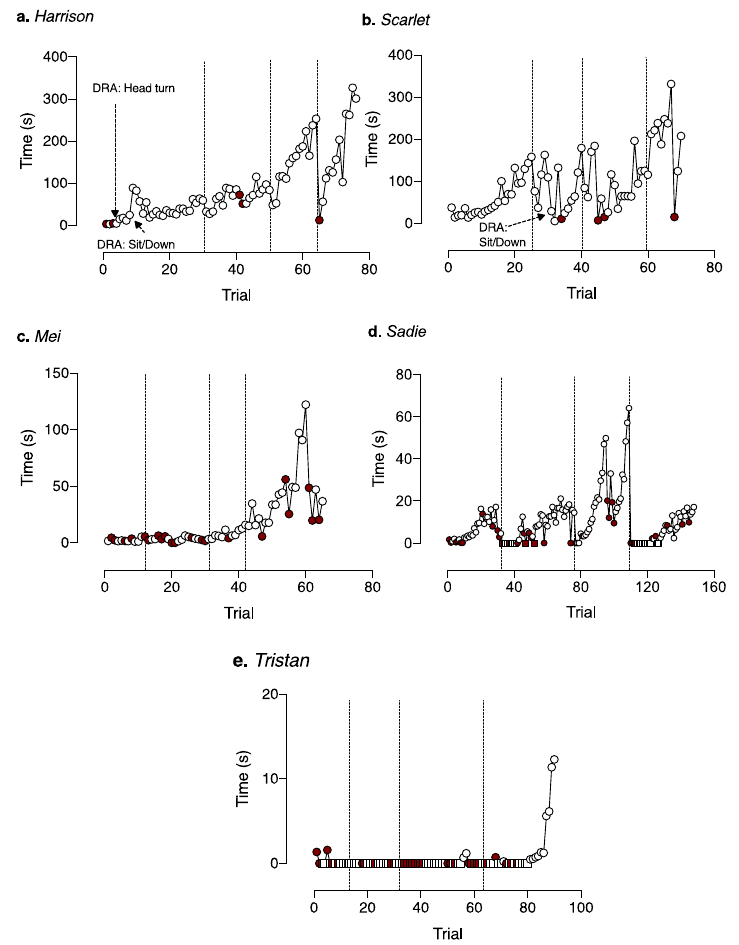
Figure 3. Trial-by-trial data for each dog ( a. Harrison; b. Scarlet; c. Mei; d. Sadie; e. Tristan) during Treatment. On each trial, we plotted either the time the dog was alone (for successful trials with no PB; open symbols) or the latency to PB on unsuccessful trials (filled symbols). Circle symbols indicate that the criteria were such that the owner was exiting the house on that trial. Square symbols indicate criteria were such that the owner was staying inside the house on that trial. For all trials in which the owner remained in the house, time dog was alone are recorded as 0 s. Latency to any PB that occurred while the owner was still in the house was recorded as 0 s. Thus, open circles with latency 0 s